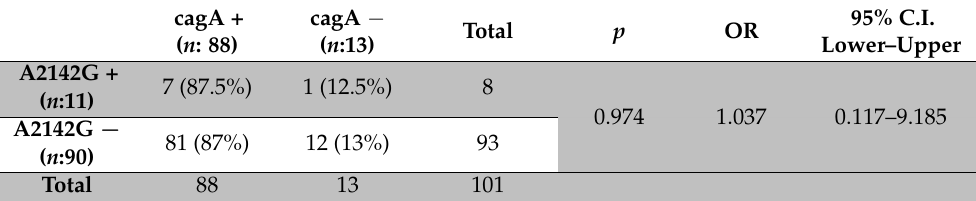
Table 8. The distribution of A2142G mutation by cagA status in all age groups.